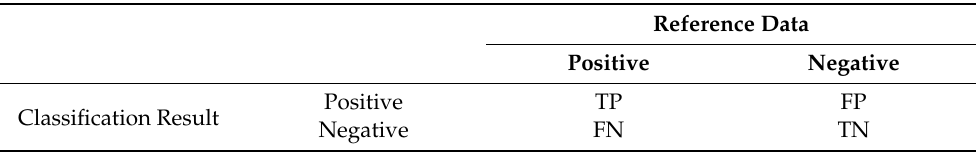
Table 2. The binary classification confusion matrix. TP = True Positive, TN = True Negative, FP = False Positive, and FN = False Negative.